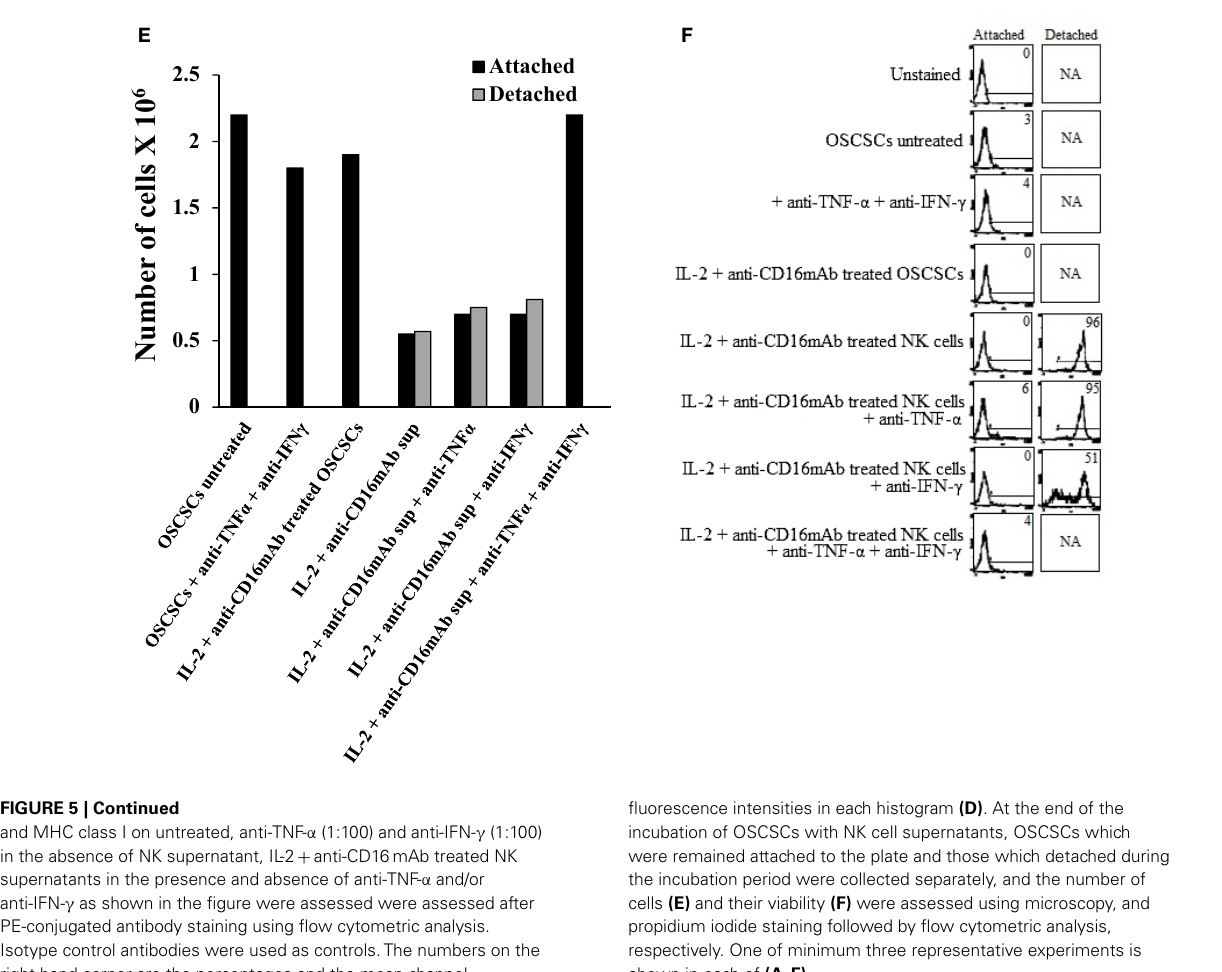
( Figure 6K ) when compared to IL-2 + anti-CD16 mAb-treated fixed NK cells in the absence of monensin treatment. Treatment of NK cells with the combination of IL-2 + anti-CD16 mAb